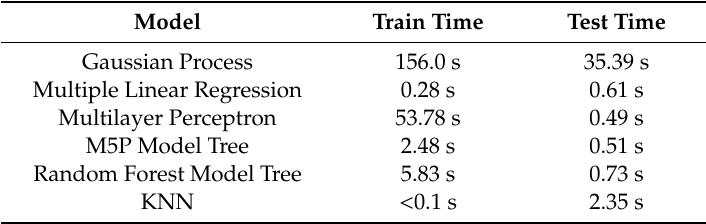
Table 5. Time to train and test multiple ML